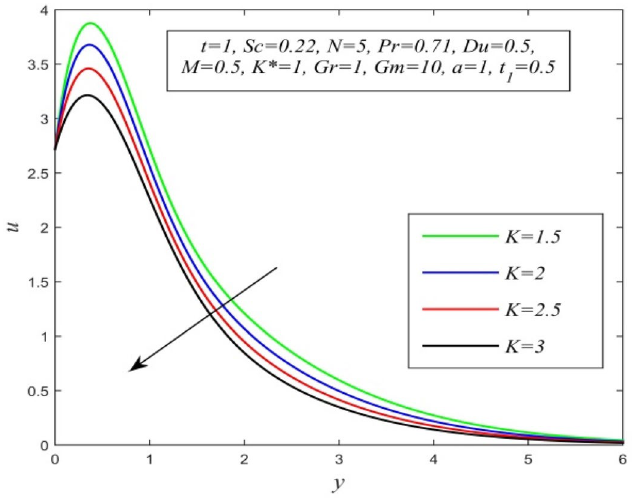
Figure 13. u versus y for different K and t = 1, Sc = 0.22, N = 5, Pr = 0.71, Du = 0.5, M = 0.5, K* = 1, Gr = 1, Gm = 10, a = 1, t 1 = 0.5.